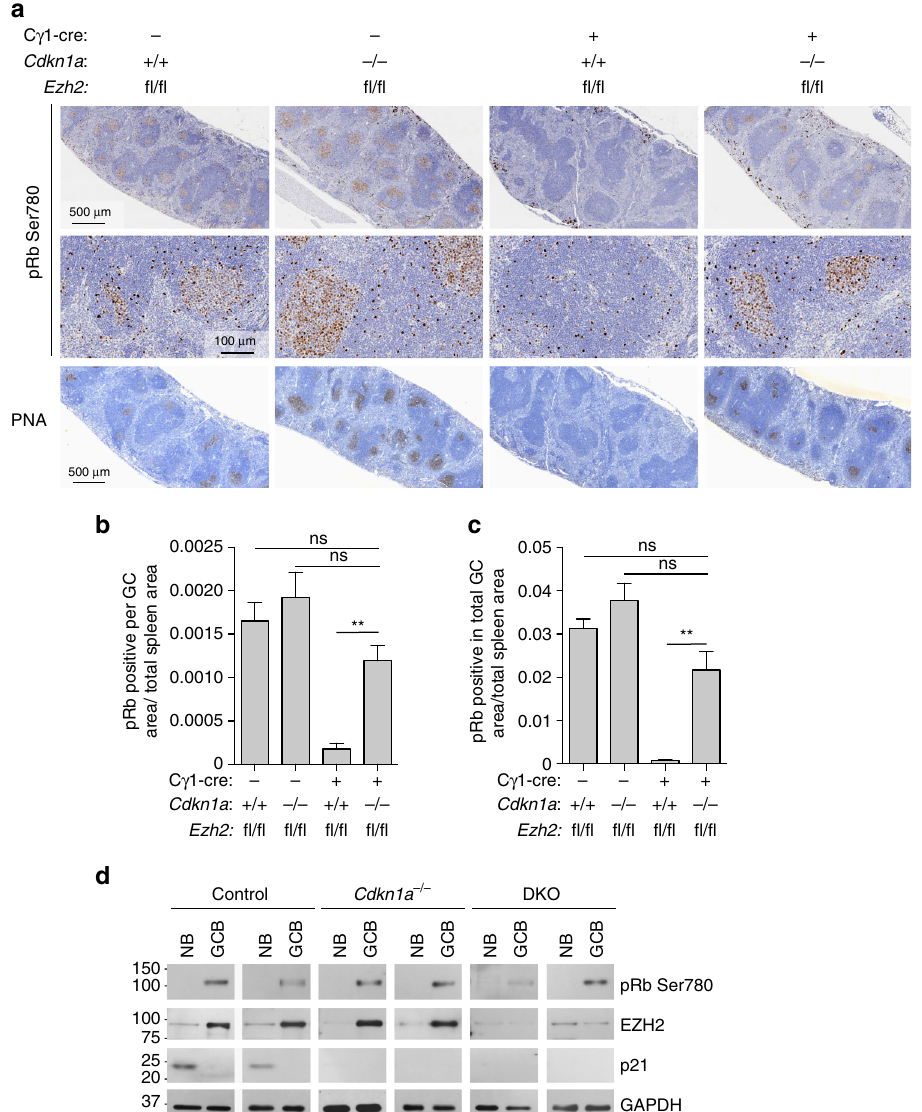
Fig. 5 EZH2 is required to enable Rb phosphorylation in GC B cells. a Formalin fi xed paraf fi n embedded splenic tissue from mice shown in Fig. 1 was stained for phospho Rb Ser780 and PNA. One representative picture of three spleens analyzed per genotype group is shown. b , c Quanti fi cation of phospho Rb Ser780 staining from a ( n = 3 spleens per group). b “ pRb positive per GC area/total spleen area ” is the quanti fi ed area of each individual GC divided by the total area of the spleen section. c “ pRb positive in total GC area/total spleen area ” is the sum of all GC quanti fi ed areas in a certain section divided by the total area of that spleen section. Values are shown as mean of triplicates ± SEM. t test, ** P < 0.01. d Immunoblotting of whole cell lysates from naive B